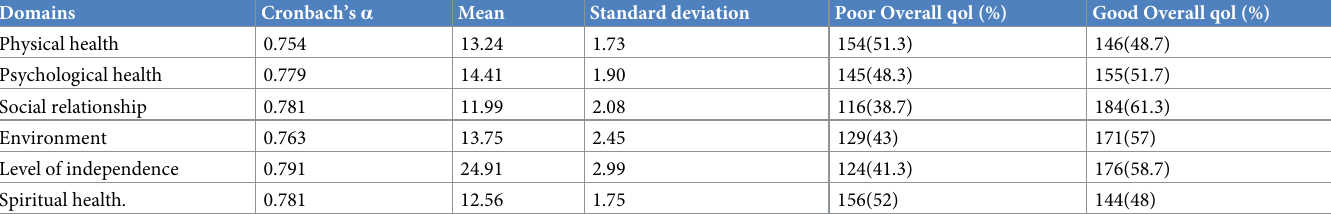
Table 4. Mean domain scores of quality of life of respondents on quality of life among PLHIV in Jimma zone public hospitals, South-west